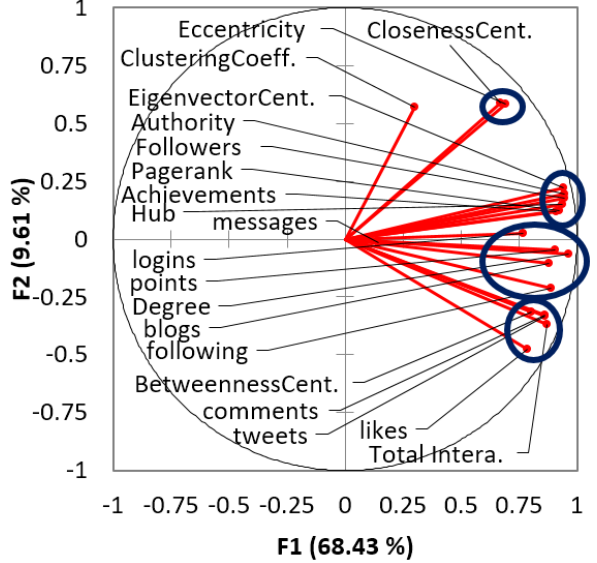
Figure 4. Principal component analysis (PCA) factor loading biplot for the experimental group.